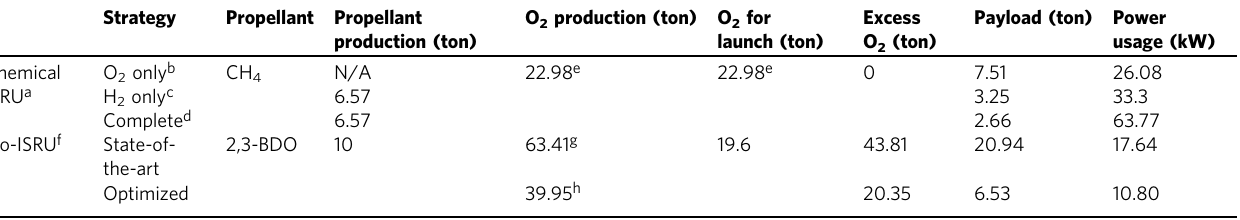
Table 1 Comparison of proposed in situ resource utilization (ISRU) strategies for rocket propellant production on Mars. Strategy